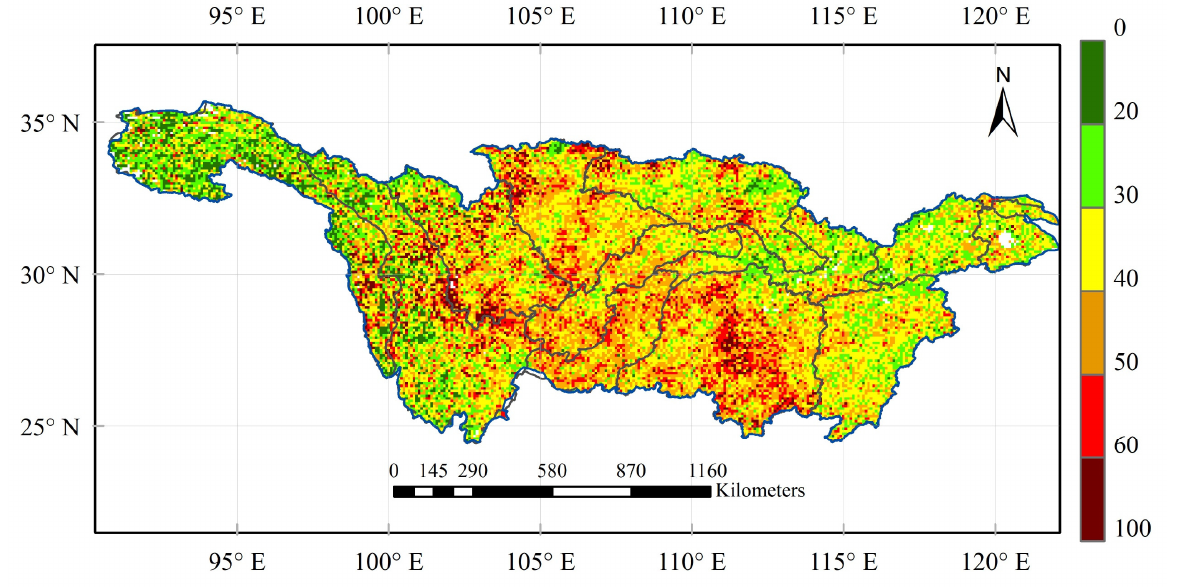
Figure 4. Spatial distribution of the VSI in the YZRB.